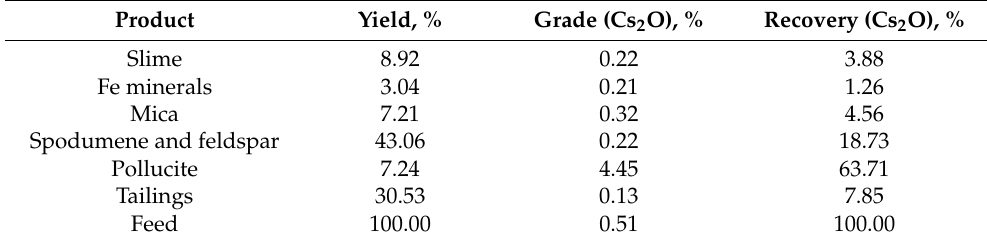
Table 8. Pollucite beneficiation